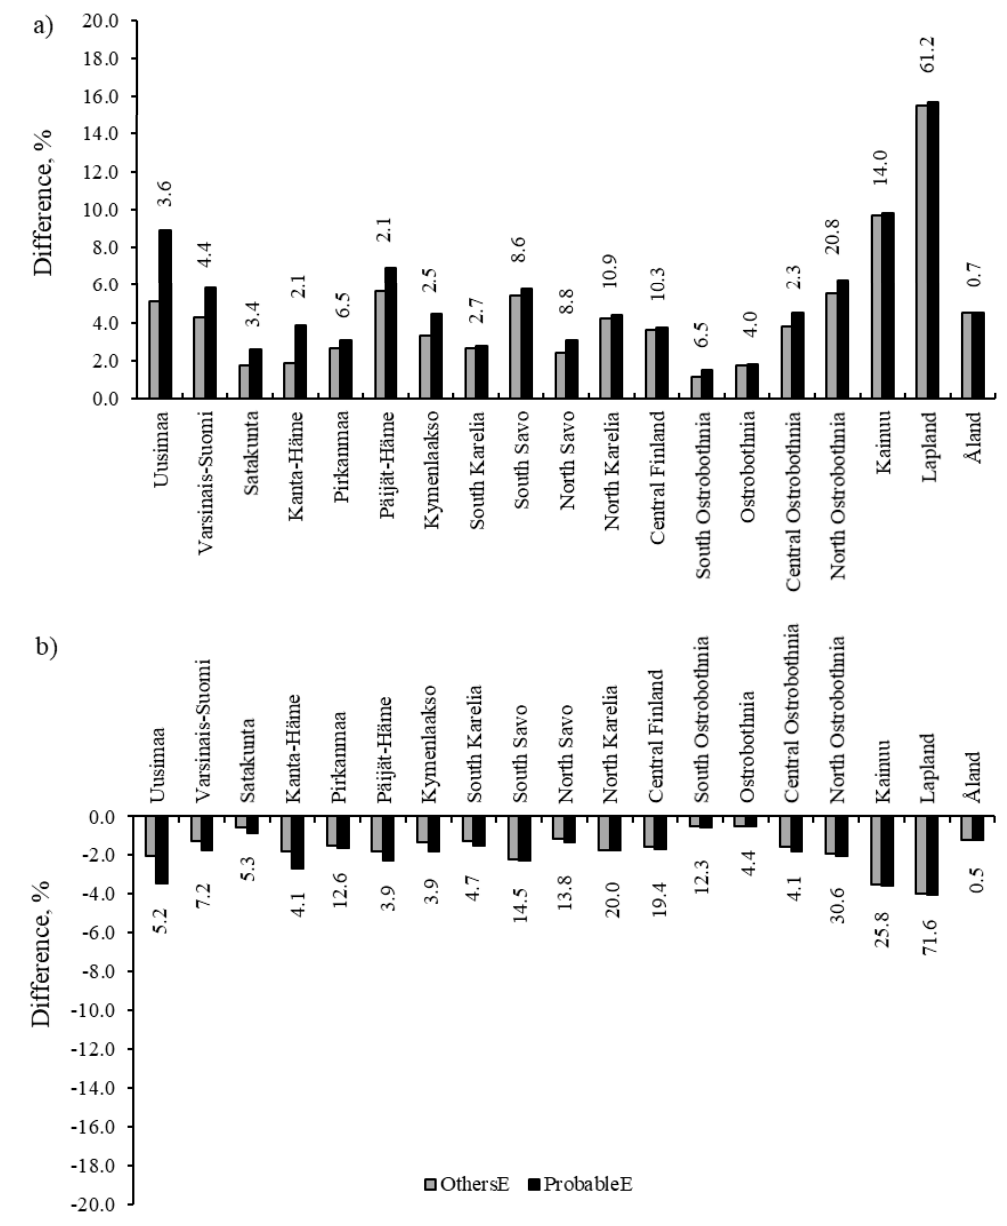
Figure 6. Differences in ( a ) bilberry and ( b ) cowberry yields in OthersE and ProbableE compared to WRE in different provinces in Finland. The numbers above/below the bars represent the estimated bilberry and cowberry yields (million kg year − 1 ) in forest land in each province in WRE in